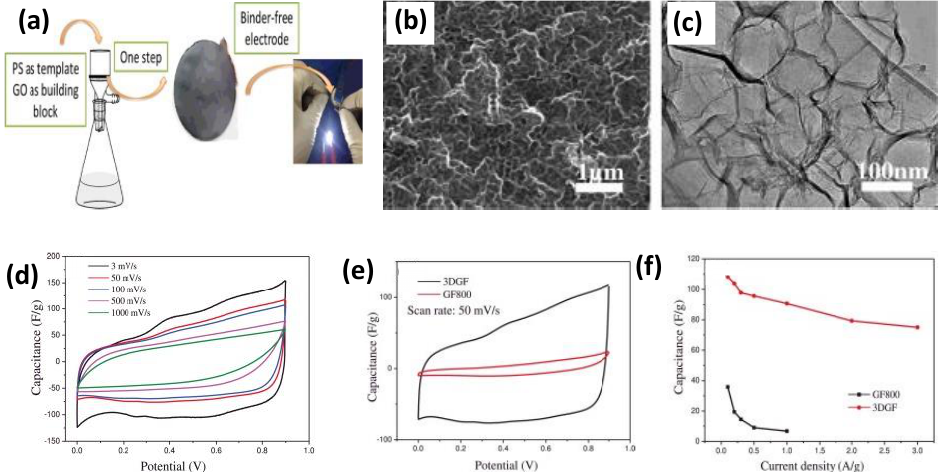
Figure 5. ( a ) Schematic illustration of binder-free electrode preparation. ( b ) Low-magnification SEM micrograph of 3DGF surface. ( c ) TEM image of 3DGF (high magnification). ( d ) CV curves of 3DGF at various scan rates. ( e ) Comparative CV curves of 3DGF and GF800 at 50 mV/s scan rate. ( f ) Calculated specific capacitance of 3DGF and GF800 at various current densities. Reproduced with permission [44] Copyright © 2022 Elsevier B.V. All rights